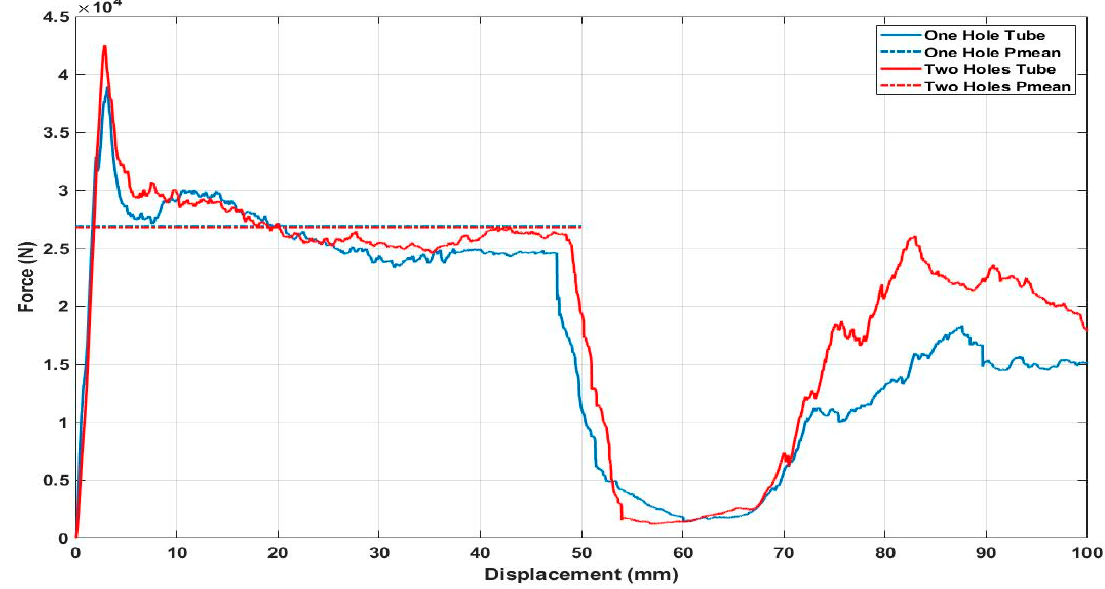
Figure 9. Force–displacement curves for the tubes with 15 mm hole, 75 mm from chamfered top (average).